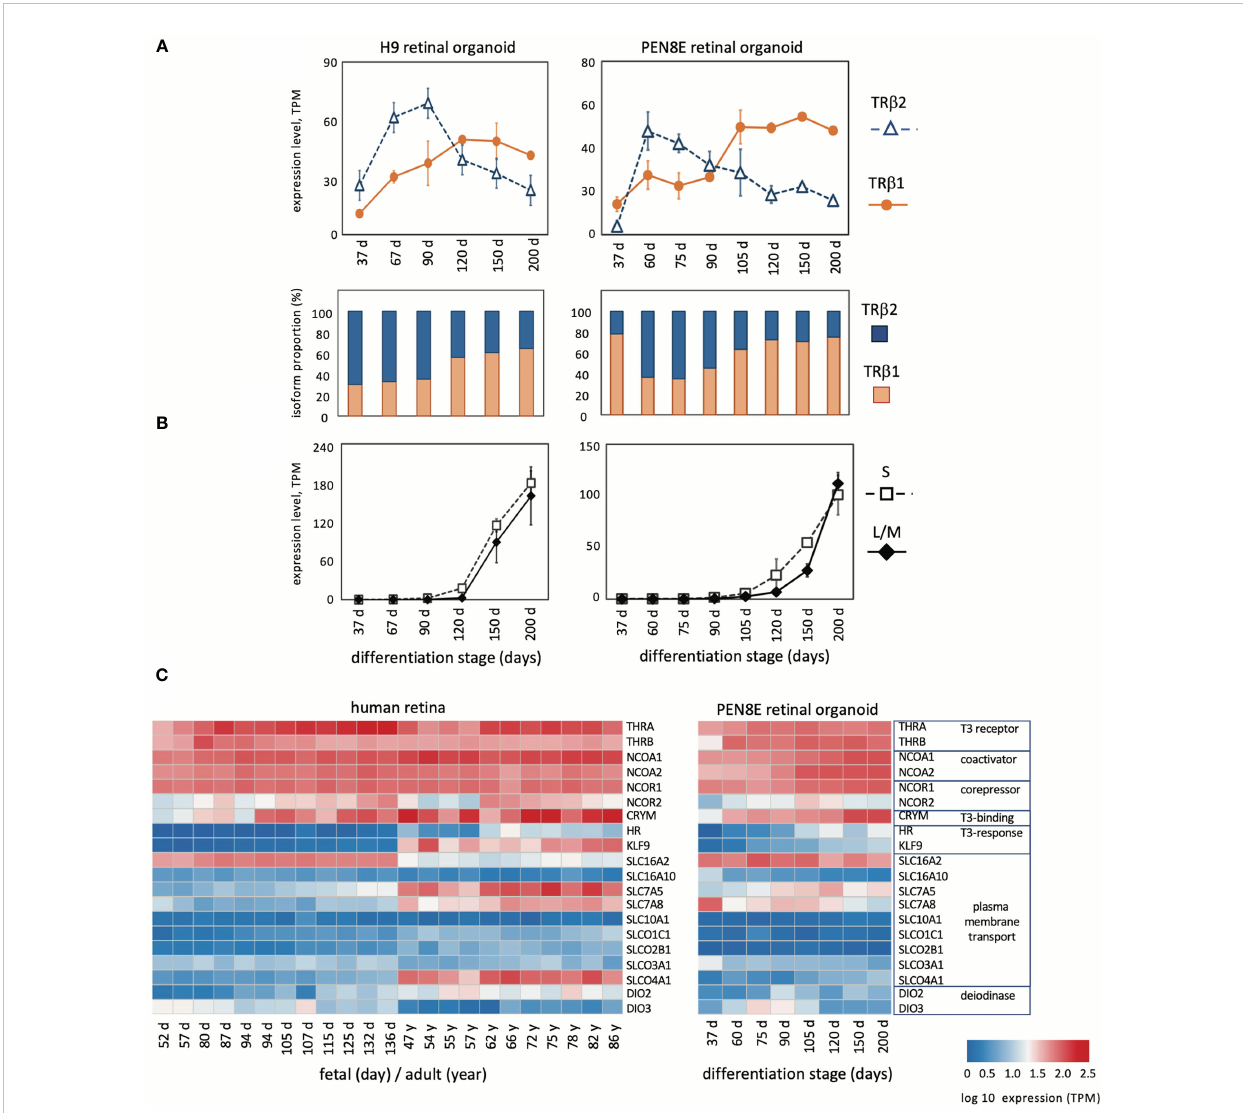
FIGURE 2 Expression of THRB and other genes in human retinal organoids and retina. (A) , RNA-seq analysis of TR b 1 and TR b 2 in H9 organoids and PEN8E organoids, derived from embryonic stem cells and iPSC lines, respectively. Mean ± S.D. The relative proportion of each isoform is indicated in the column graph, below. (B) , Cone opsin expression in the same RNA-seq datasets. OPN1SW , blue (S) opsin and OPN1LW-OPN1MW , red/green (L/M) opsins; the L/M curve represents reads from both genes in the OPN1LW-OPN1MW gene cluster. (C) , Heatmaps of expression of indicator genes for thyroid hormone signaling in human retina and PEN8E retinal